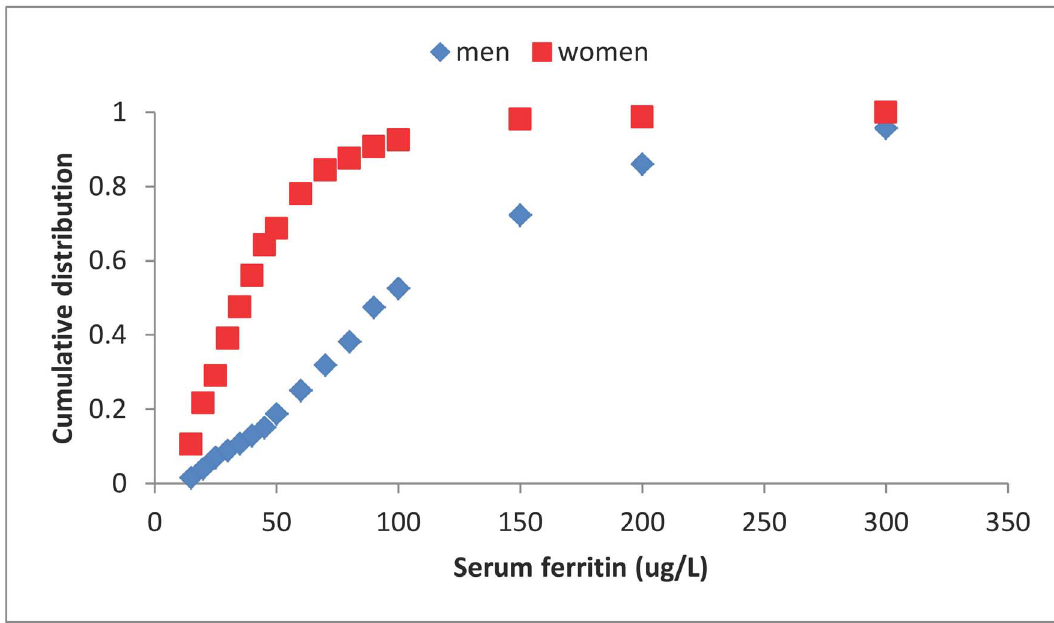
doi:10.1371/journal.pone.0111824.g002